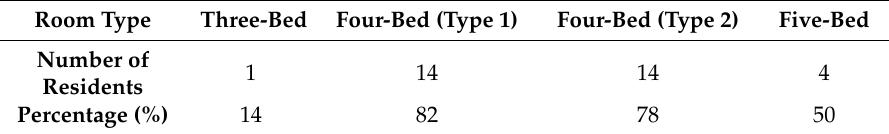
Figure 11. Colour-coded sequential patterns. This chart illustrates the number of visited locations per resident. Table 3. Number of residents involved in more than 48 locations in a day.